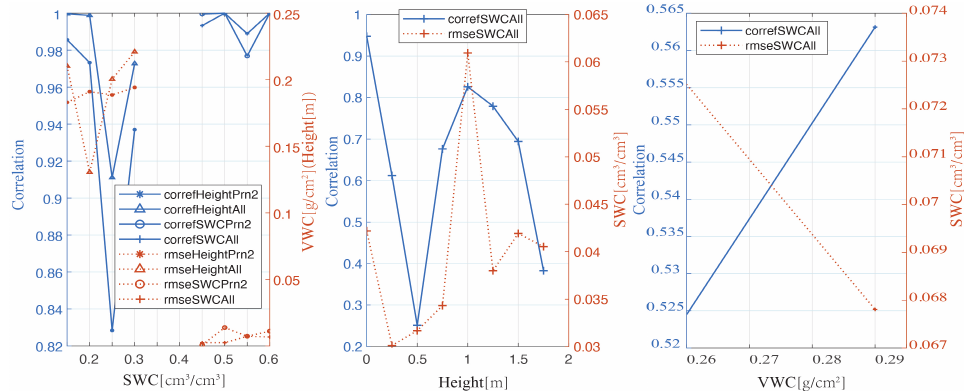
Figure 14. Retrieval’s accuracy